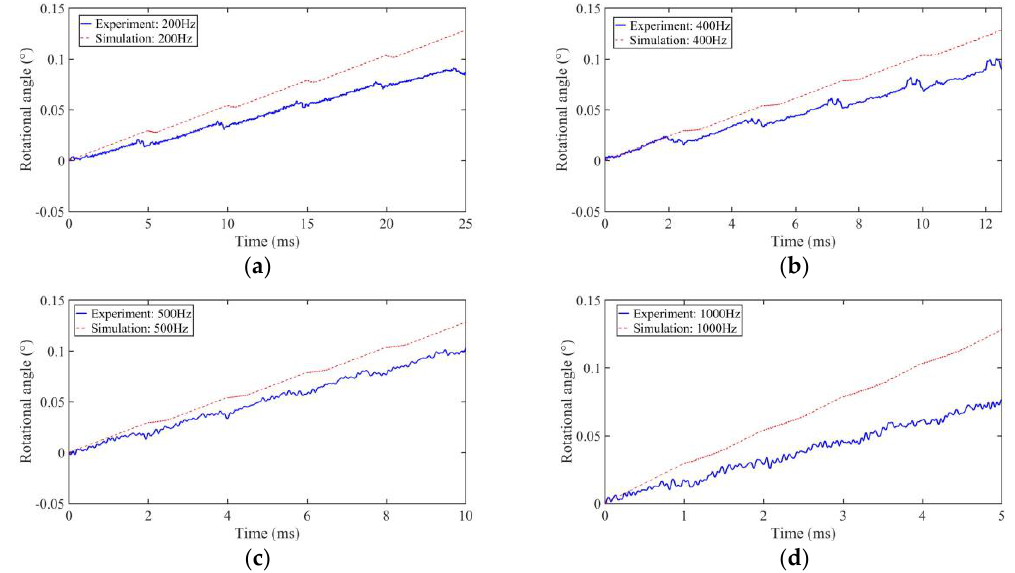
Figure 11. Stepping characteristics of the prototype motor under different driving frequencies in experiments and simulations: ( a ) 200 Hz; ( b ) 400 Hz; ( c ) 500 Hz; ( d ) 1 kHz. experiments and simulations: ( a ) 200 Hz; ( b ) 400 Hz; ( c ) 500 Hz; ( d ) 1